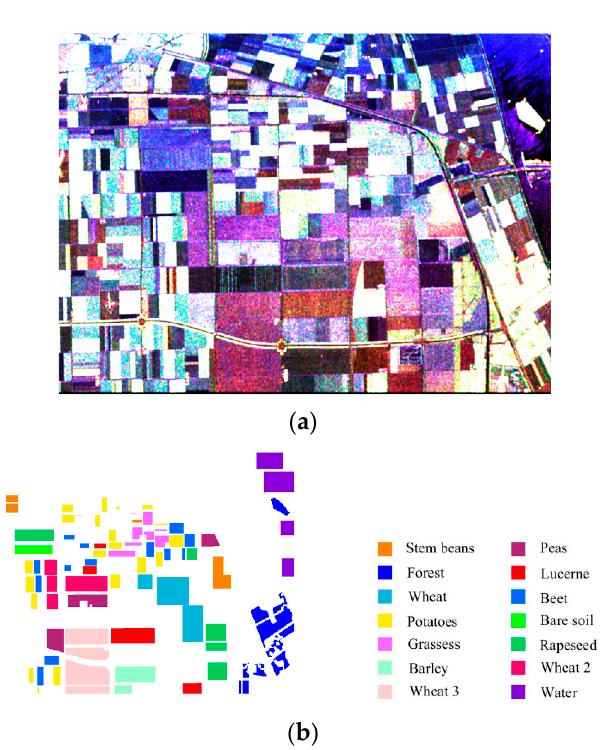
Figure 10. Pseudo-color image and ground truth of AIRSAR data over Flevoland. ( a ) Pseudo-color image. ( b ) Ground truth with terrain-type labels.